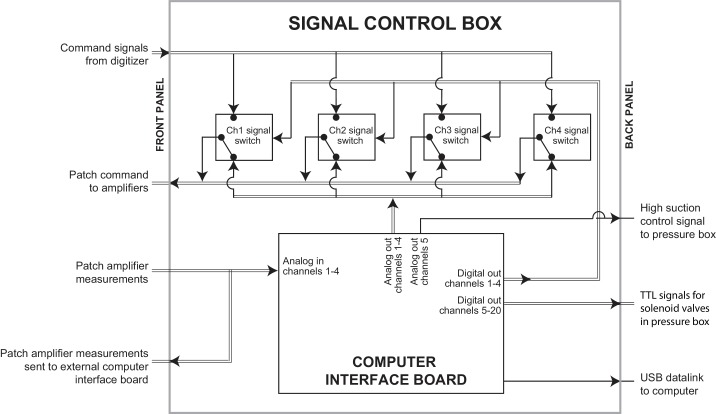
Schematic of the pressure control box.The pressure control box was designed to independently apply four possible pressures to each of the four pipettes. The pressure control box received compressed air at approximately 2.75 bar and vacuum pressure at approximately −1.5 bar. It regulated these input pressures to the required pressures using a series of manual and electronically controlled pressure regulators that fed into a pneumatic valve bank. this pneumatic valve bank switched the pipettes between pressure states during the multipatcher operation.